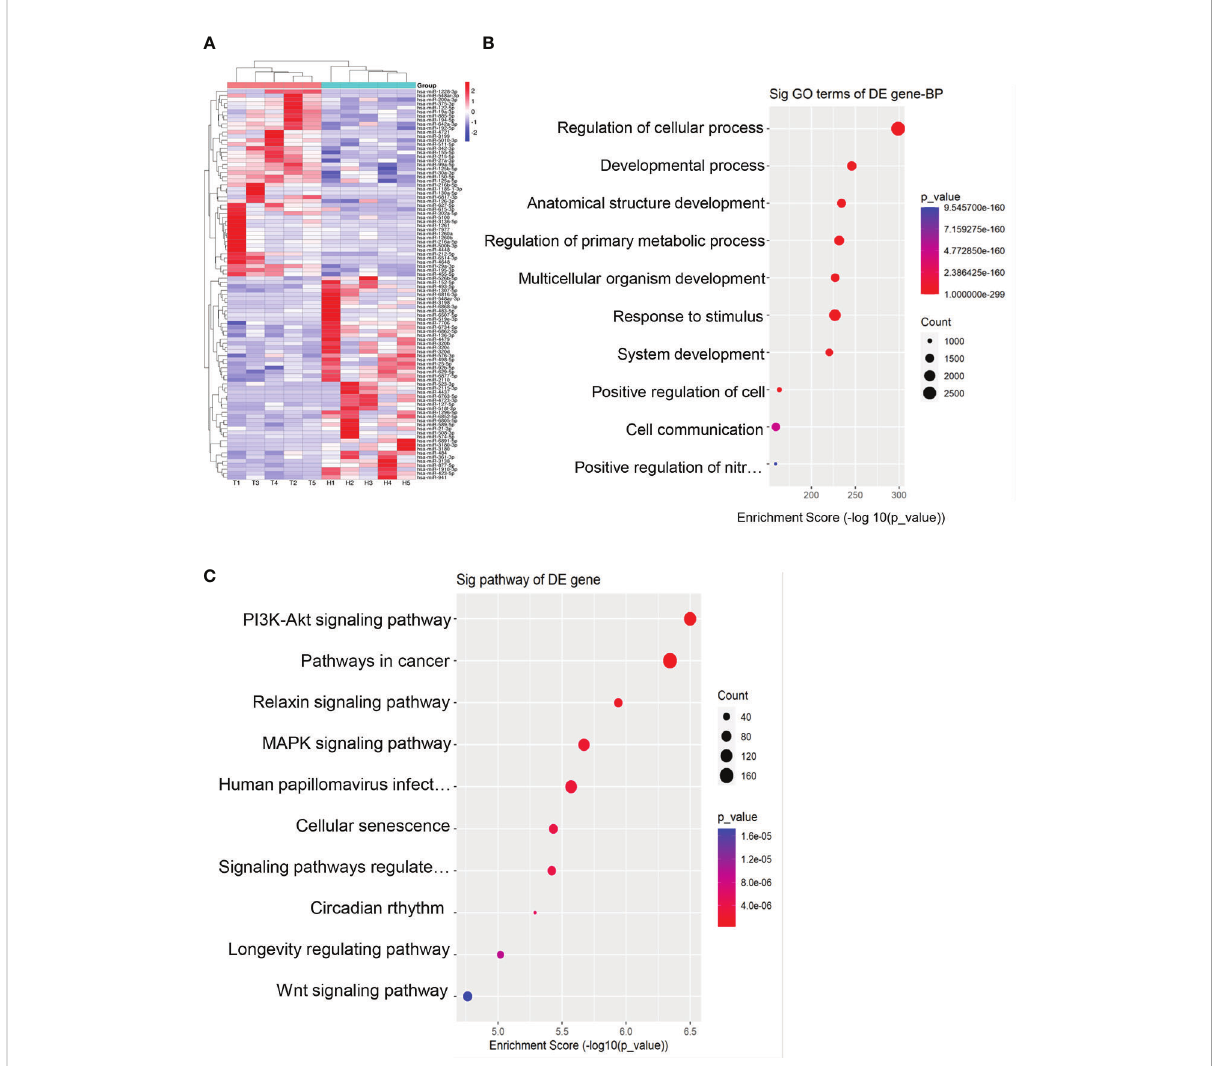
FIGURE 2 Exosomal miRNAs pro fi le of the EOC patients. (A) A heat map was generated after supervised hierarchical cluster analysis. The differential exosomal miRNAs expression is shown in red (upregulation) or blue (downregulation) ( P < 0.05). (B) . Candidate target gene GO enrichment analysis. (C) Candidate target gene KEGG enrichment